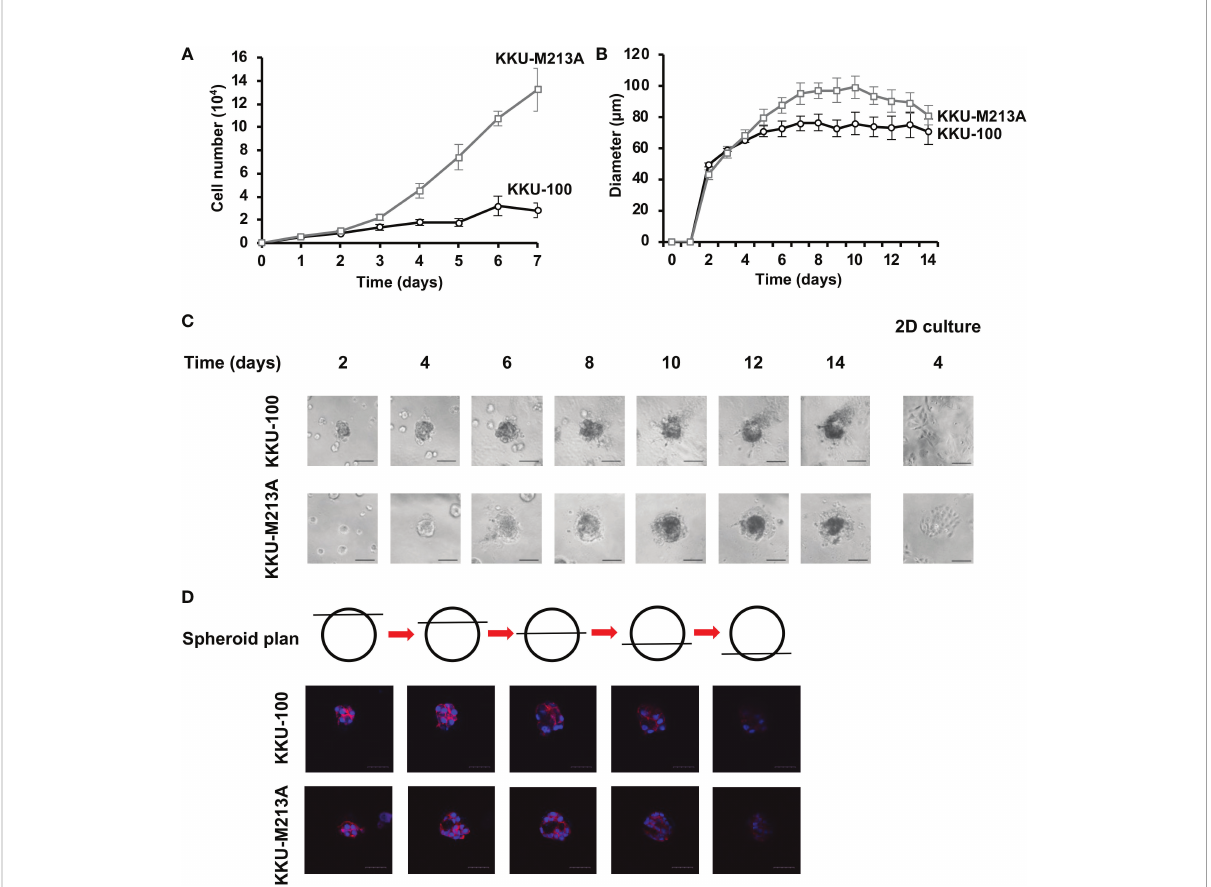
FIGURE 1 The growth rate of CCA cells in 2D and 3D cultures. (A) The growth rate of CCA cells in 2D culture as determined by cell counting. The cell numbers were counted every 24 h. Black circle and grey square represent KKU-100 and KKU-213A cells, respectively. (B) The growth rate of CCA cells in 3D culture as determined by diameter measurement. The diameter was measured every 24 h. Black circle and grey square represent KKU-100 and KKU-213A cells, respectively. The data represent means and ± standard error. (C) The tumor spheroid morphologies of KKU-100 and KKU-213A cells in 3D Matrigel-overlayed culture. The images were taken every 2 days using a phase-contrast microscope. The scale bars represent 100 µm. (D) Cellular organization of CCA spheroids. KKU-100 and KKU-213A cells were grown in 3D culture for 6 days. The CCA spheroids were permeabilized, blocked and subsequently stained with Hoechst 33342 for nucleus and TRITC-phalloidin for F-actin. Their structures were observed under a confocal microscope and Z-stack images were obtained. Red represents F-actin and blue represents nuclei. The scale bars represent 100 m